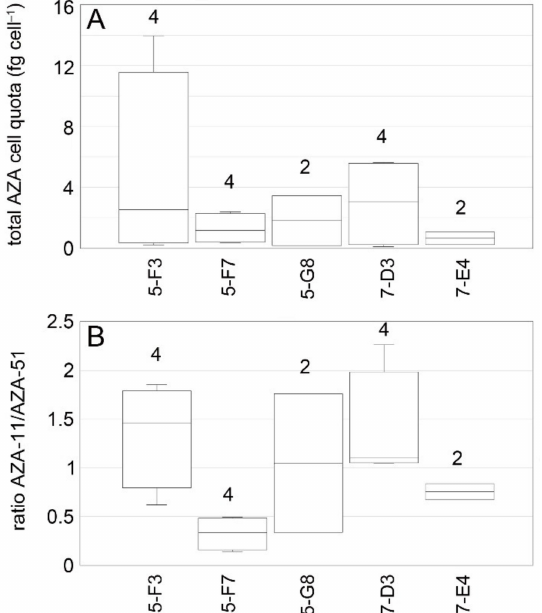
Figure 12. Azadinium spinosum ribotype B strains. Variability in total AZA cell quota ( A ) and AZA ratio ( B ) based on multiple analyses of single strains. Number above bars indicate the number of analyses ( n